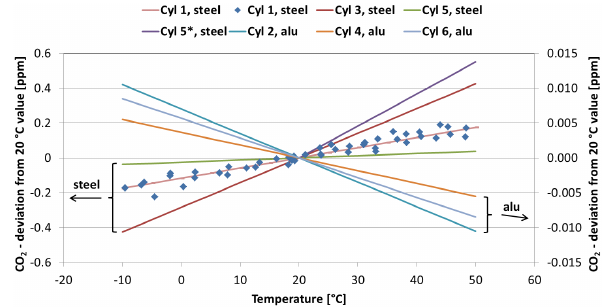
Figure 6. Temperature dependence for the CO 2 mole fraction de- viations from their corresponding value at 20 ◦ C ( T 0 ) for the steel cylinders 1, 3, 5, 5 ∗ (increasing values, left y axis), as well as for aluminium cylinders 2, 4, 6 (decreasing values, right y axis). The y axes are different by a factor of 40. For clarity, measurements are only given for cylinder 1 (measurements for cylinder 2 are displayed in Fig. 8), together with its linear correlation line, whereas for the other cylinders, only linear correlations lines are given. The tem- perature dependencies vary between 0.0014 and 0.0184ppm ◦ C − 1 for steel and − 0.0002 and − 0.0003ppm ◦ C − 1 for aluminium cylin-